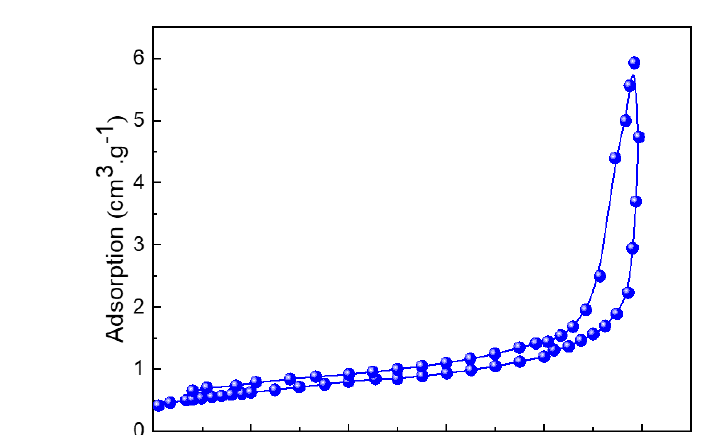
Figure 2. SEM images of Ag 3 PO 4 .